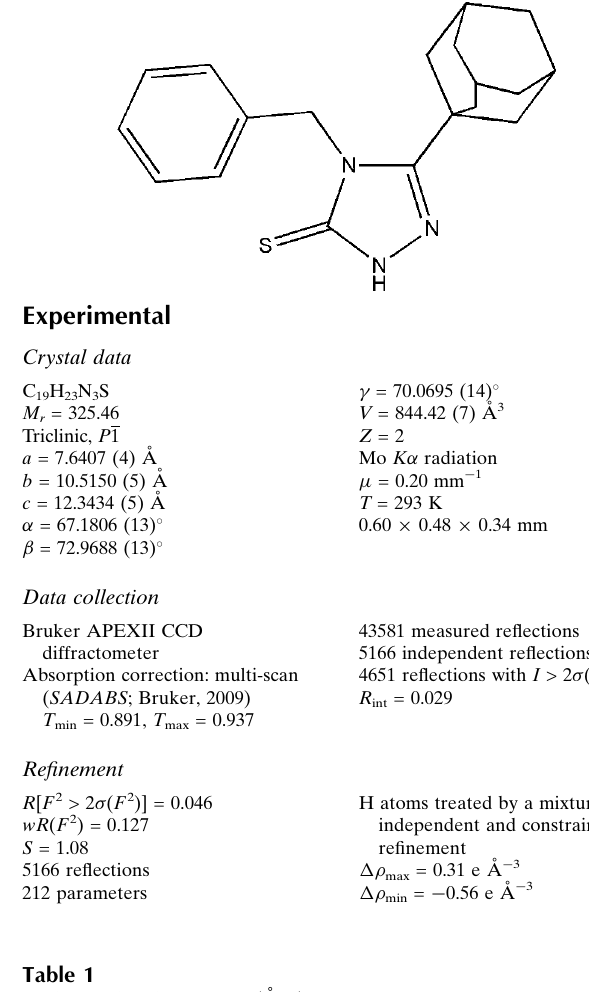
Hydrogen-bond geometry (A˚ , (cid:2)